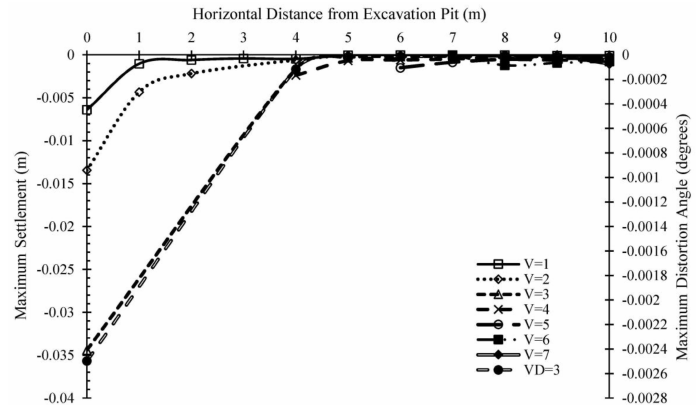
Fig. 7. Settlement at Point B and Angle of Distortion for Scenario 3